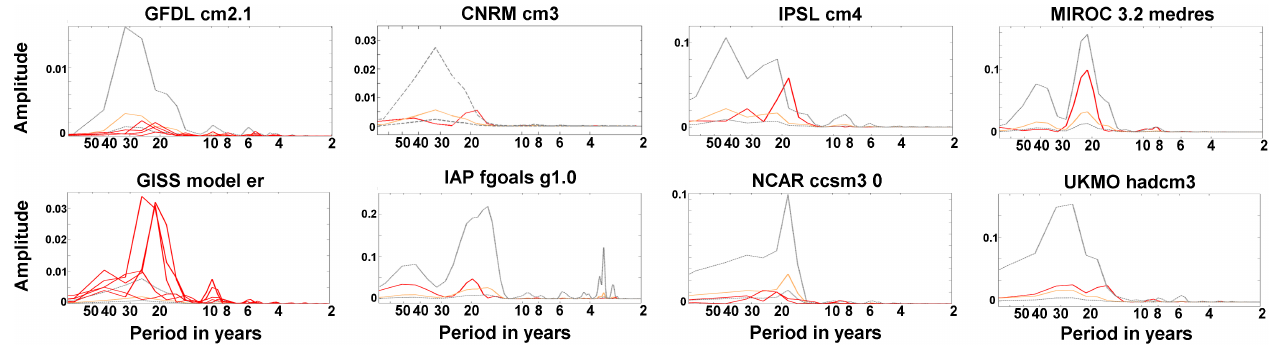
Fig. 9. Power spectra of the first PC of the set of 17-yr trend maps computed with the coupled climate models. The red curves indicate the power spectra of the 20c3m runs while the orange curves indicate the power spectra of their respective control runs. The grey dashed lines indicate the 95% confidence level computed from the control runs.